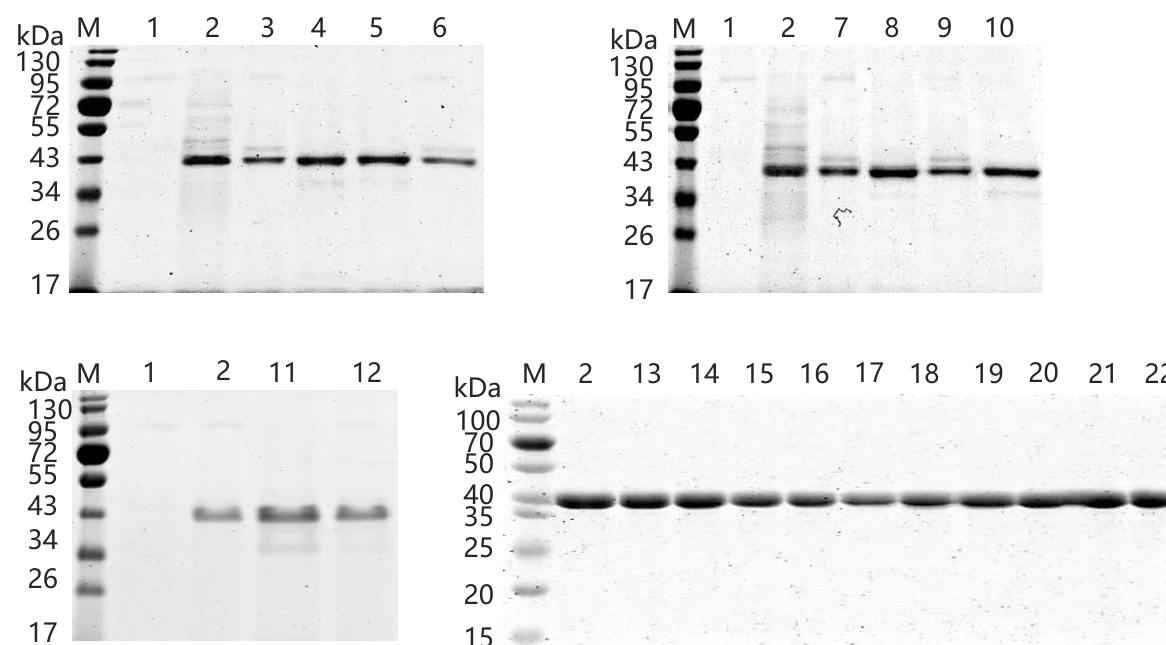
Figure 1. SDS-PAGE analysis of purified recombinant proteins of wild type AX543 and its variants. Lane M, molecular mass marker; Lane 1, the intracellular supernatant of plasmid pET28a(+) expressed in E. coli ; Lane 2, wild type AX543; Lane 3, mutant L1; Lane 4, mutant L2; Lane 5, mutant L3; Lane 6, mutant L4; Lane 7, mutant K125P; Lane 8, mutant A119P; Lane 9, mutant G216A; Lane 10, mutant G110S; Lane 11, mutant Q201R; Lane 12, mutant K285R; Lane 13, chimera R1; Lane 14, chimera R2; Lane 15,chimera R3; Lane 16, chimera R4; Lane 17, chimera R5; Lane 18, chimera R6; Lane 19, chimera R7; Lane 20, chimera R8; Lane 21, chimera R9; Lane 22, chimera R10.